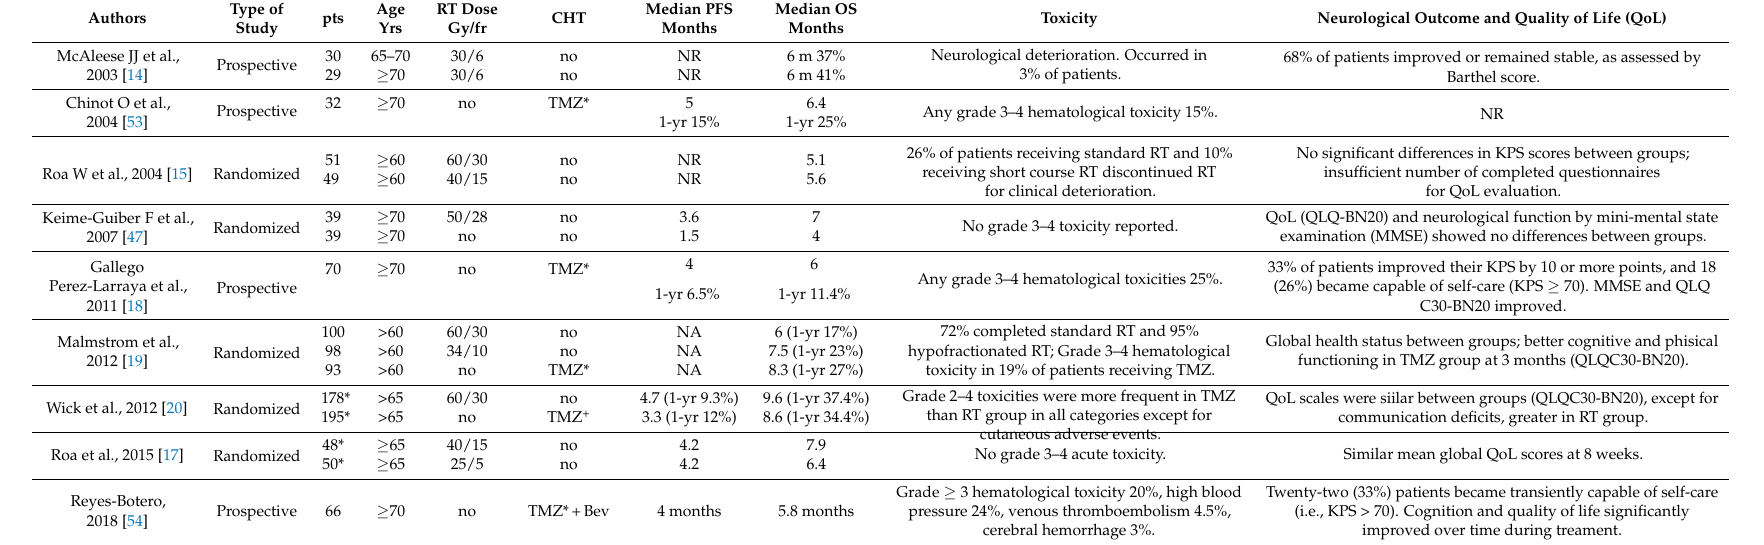
Table 1. Selected prospective studies on radiotherapy or chemotherapy in older patients with